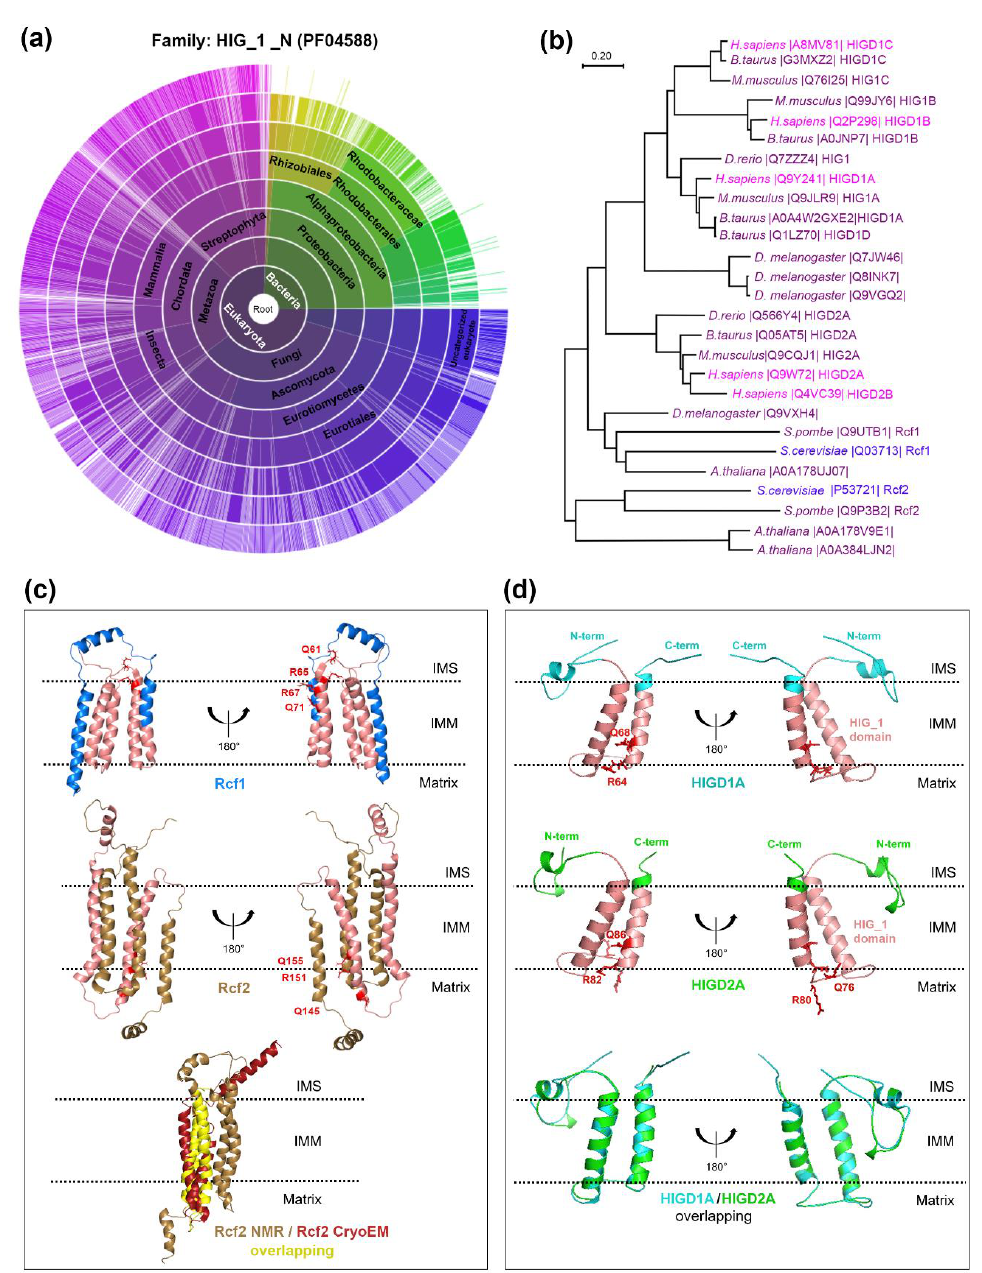
Figure 1. Distribution of HIG_1_N (PF04588) domain proteins across species. ( a ) Modified “sunburst” visualization of the taxonomic lineage distribution of 1911 different species that in total have 3472 protein sequences containing the hypoxia-inducible gene (HIG)-1-N domain (Pfam ID: PF04588). The graph shows each node in the tree as a separate arc, arranged radially with the superkingdoms at the center and the species arrayed around the outermost ring. The graph was generated with tools from pfam.xfam.org hosted by the European Bioinformatics Institute at the European Molecular Biology Laboratory (EMBL-EBI). Yellow-green colors represent different types of bacteria, and purple color represent eukaryotes. ( b ) Phylogenetic tree of Hypoxia-inducible gene domain (HIGD) proteins across eukaryotic species. The evolutionary history was inferred using the Neighbor-Joining method. We show the optimal tree with the sum of branch length = 8.97673253. The tree was drawn to scale,